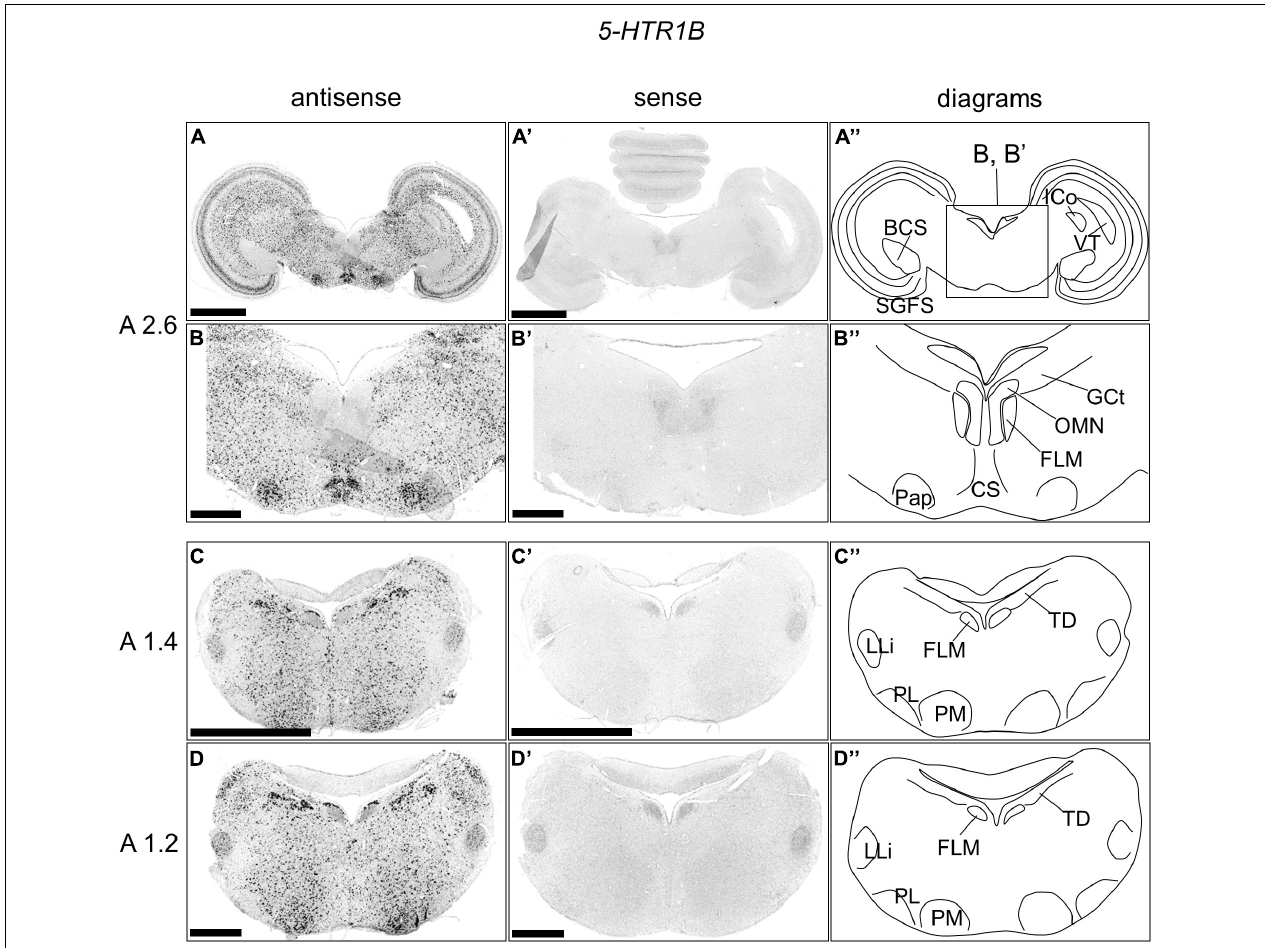
FIGURE 3 | In situ hybridization of 5-HTR1B in the P1 chick brainstems. Digoxigenin-labeled RNA antisense (A–D) and sense (A’–D’) 5-HTR1B probes were used for in situ hybridization in coronal sections of P1 chick brains. To evaluate the expression patterns of 5-HTR1B , sections of two chicks were analyzed, and representative images of chick brain sections are shown. (B,B’) Magnified views of brain areas in the box in panel (A”) are shown. (A”–D”) Diagrams of coronal sections are shown in the rightmost panels. The levels of the sections (A 2.6, A 1.4, and A 1.2) are in accordance with those mentioned in Kuenzel and Masson’s chick atlas (Kuenzel and Masson, 1988). BCS, brachium colliculi superiors; CS, nucleus centralis superior; FLM, fasciculus longitudinalis medialis; GCt, griseum centrale; ICo, nucleus intercolicularis; LLi, nucleus ventralis lemnisci lateralis; OMN, oculomotor nucleus; Pap, nucleus papillioformis; PL, nucleus pontis lateralis; PM, nucleus pontis medialis; SGFS, stratum griseum et fibrosum superficiale; SGP, stratum griseum periventriculare; TD, nucleus tegmenti dorsalis; VT, ventriculus tecti mesencephali; P1, post-hatch day 1. Scale bars = 2.5 mm (A,C,A’,C’) and 1 mm (B,D,B’,D’) .